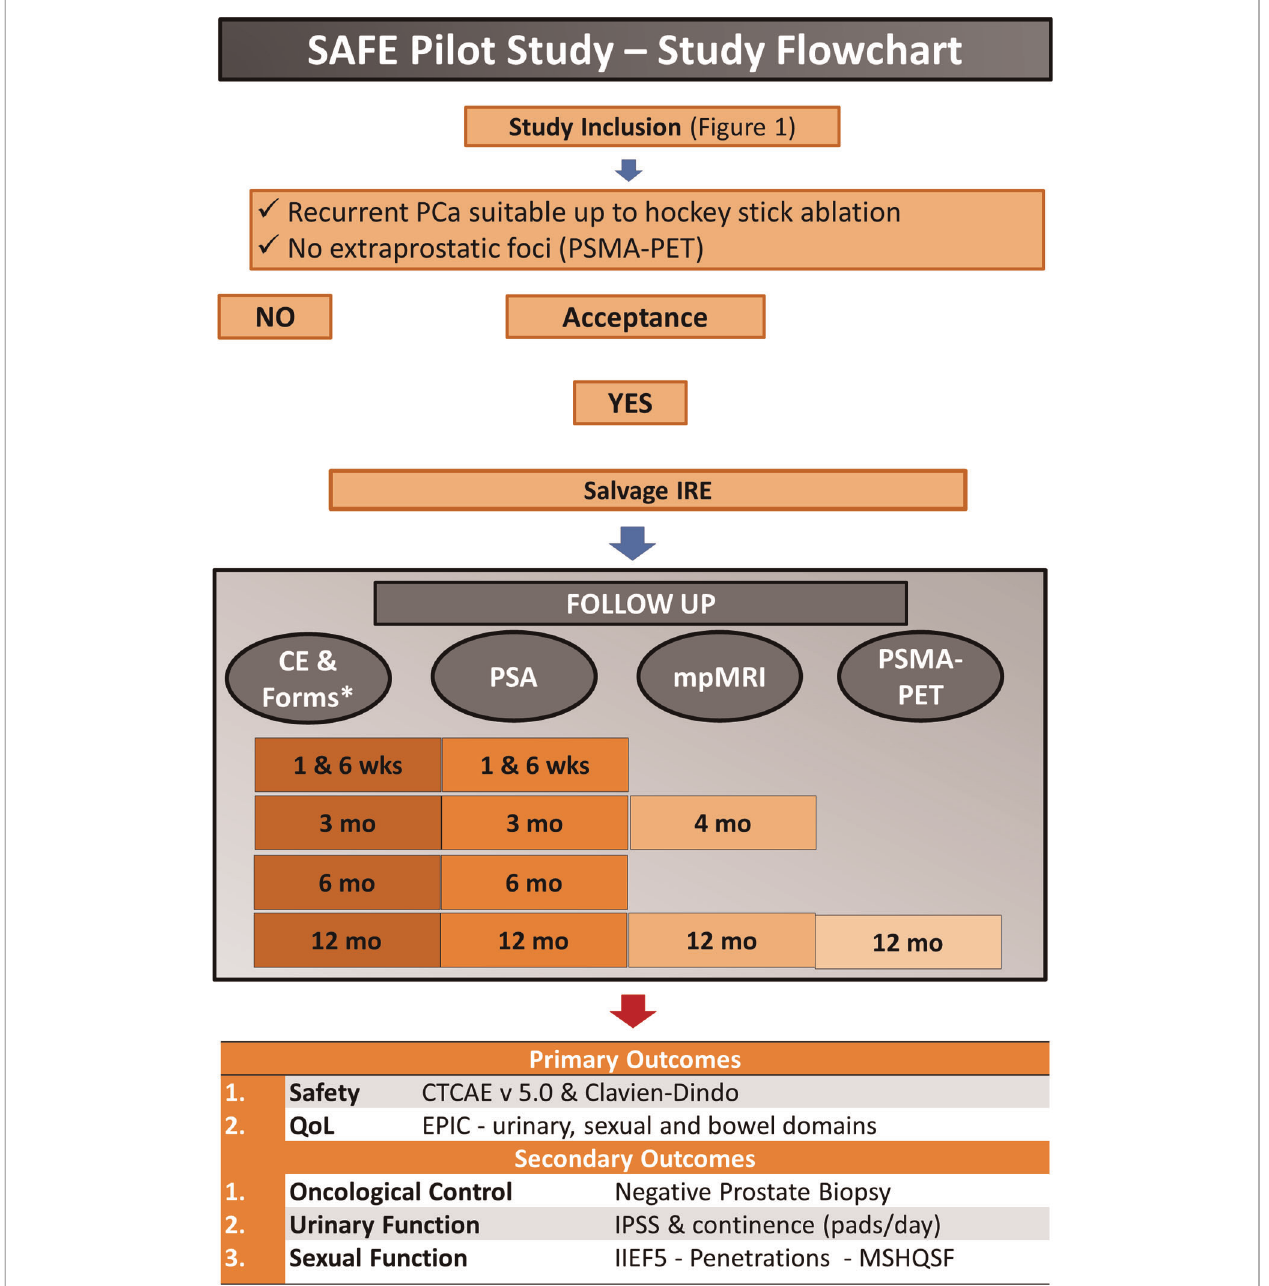
FIGURE 3 | Flowchart illustrating the different steps of the study after patient inclusion. *=Clinical examination and questionnaires; at 1 week, a phone interview will be performed instead of a clinical visit; PCa, prostate cancer; IRE, irreversible electroporation; TCAE v 5.0, National Cancer Institute Common Terminology Criteria for Adverse Events; QoL, quality of life; EPIC, Expanded Prostate Cancer Index Composite — with speci fi c urinary, sexual and bowel domains; IPSS, International Prostate Symptoms Score; IIEF-5, International Index of Erectile Function version